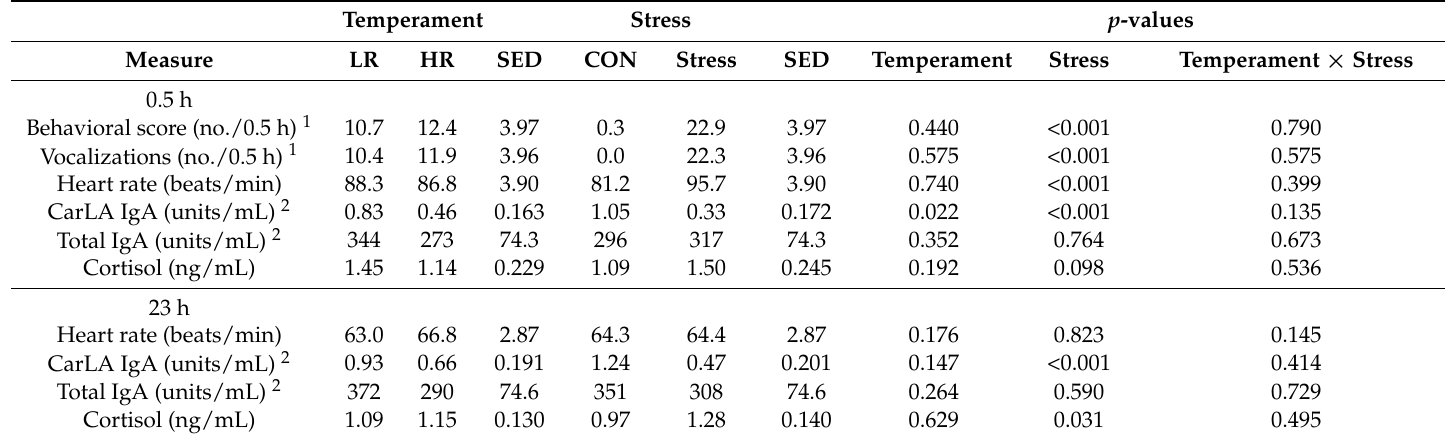
Table 3. Behavioral and physiological response of low (LR) and high (HR) reactive ewes housed in control (CON) or visually isolated (STRESS) pens after a 0.5 h and 23 h test period. Eighty ewes were allocated to one of four treatment groups in a 2 × 2 factorial design ( n = 20 ewes/treatment). CarLA = carbohydrate larval surface